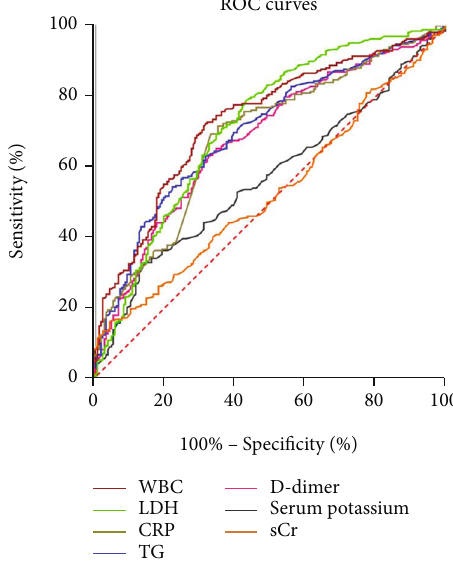
Figure 1: ROC curves of independent prognostic risk factors for AP.